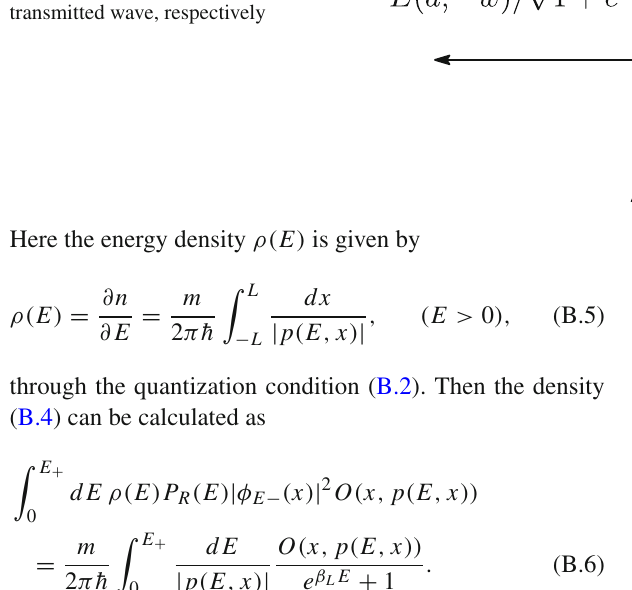
Fig. 6 The scattering of the in-coming wave E ∗ ( a , − w) through the relation (A.11). E ( a , − w) and E ( a ,w) describe the reflected wave and the transmitted wave,